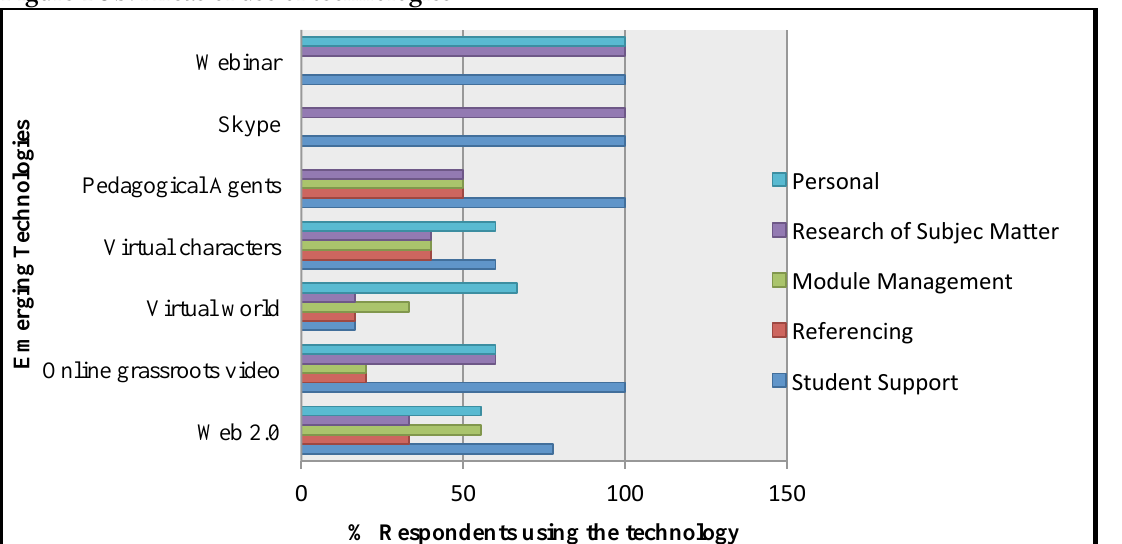
Figure 1 5b: Areas of use of